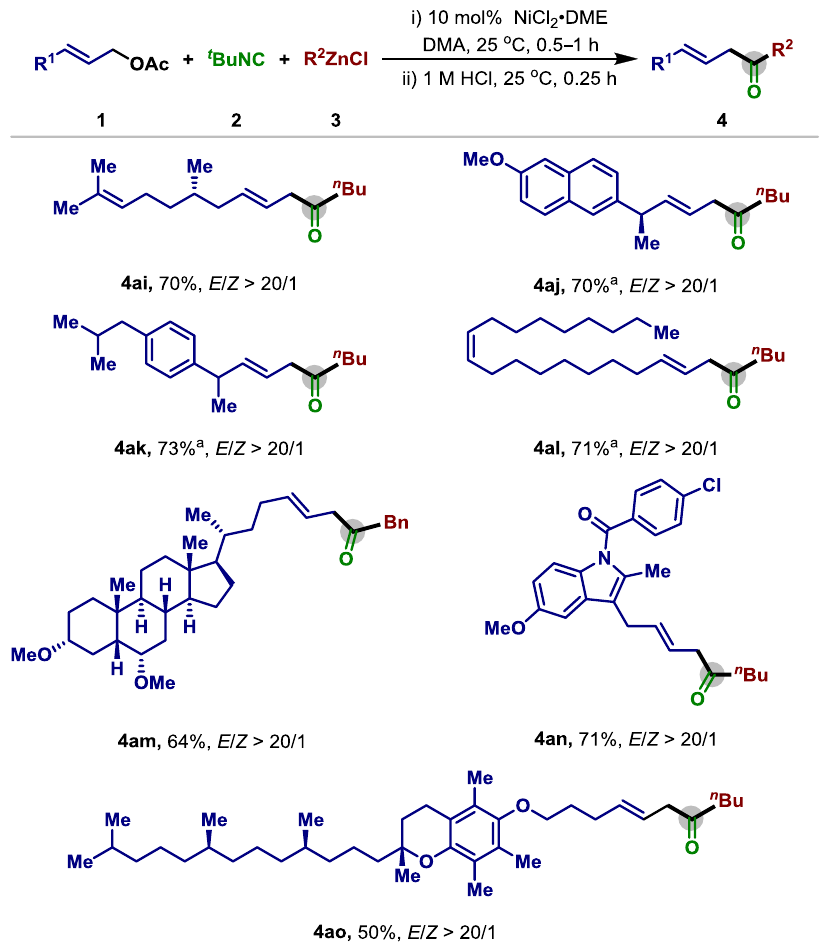
Fig. 4 Scope of biologically active allyl acetate for nickel-catalyzed allylic carbonylative Negishi reaction. Reaction conditions: 1 (0.2 mmol),